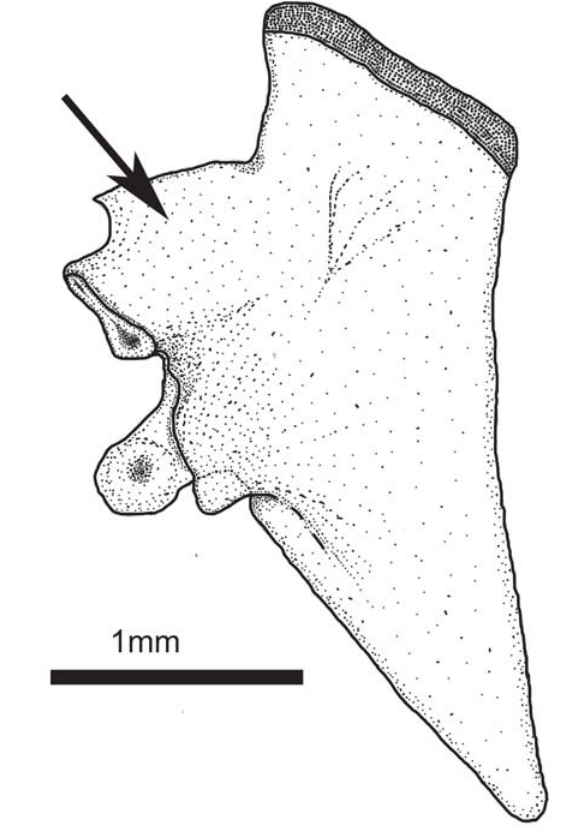
Fig. 6. Dorsal view of the right palatine of Trichomycterus igobi , MPEG 13354, paratype. Arrow indicates mesial bony